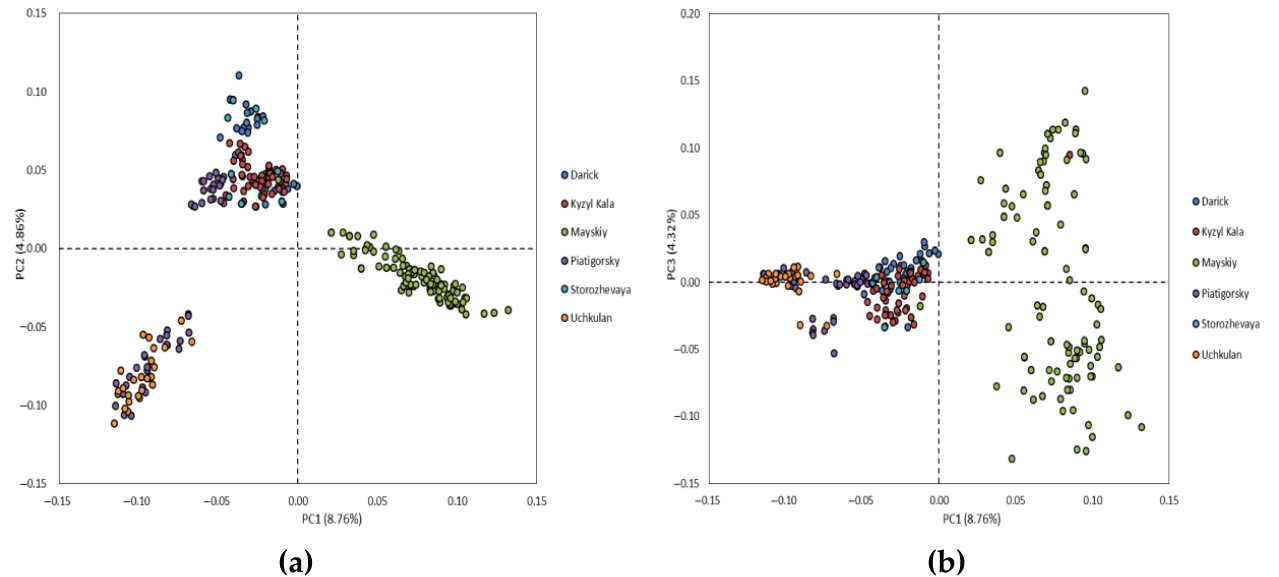
Figure 1. Population structure from the principal component analysis (PCA). PCA plots show the distribution of individuals of Karachai goats in the dimensions of two coordinates, i.e., ( a ) the first (PC1; X-axis) and second (PC2; Y-axis) principal components, ( b ) the first (PC1; X-axis) and third (PC3; Y -axis) principal components, with the percentage of total genetic variability, which can be explained by each of the two components, indicated within the parentheses; the individuals from the different herds are indicated by different colors.